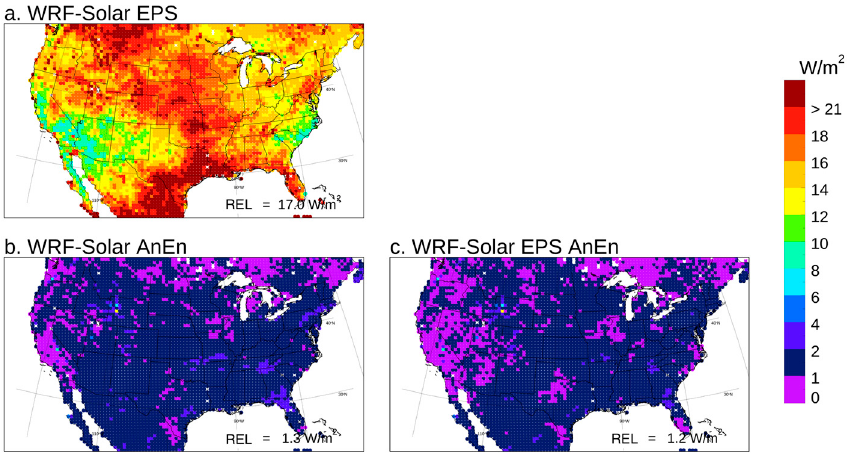
Figure 9. Potential continuous ranked probability score (CRPSPOT) map computed for GHI pooling runs and the forecast lead times from +24 to +48 h for 2018 together.